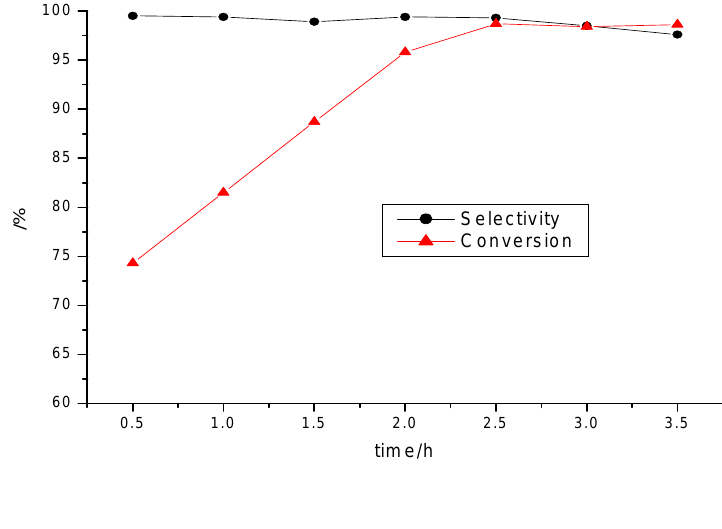
Figure 3. The effect of the reaction time on the